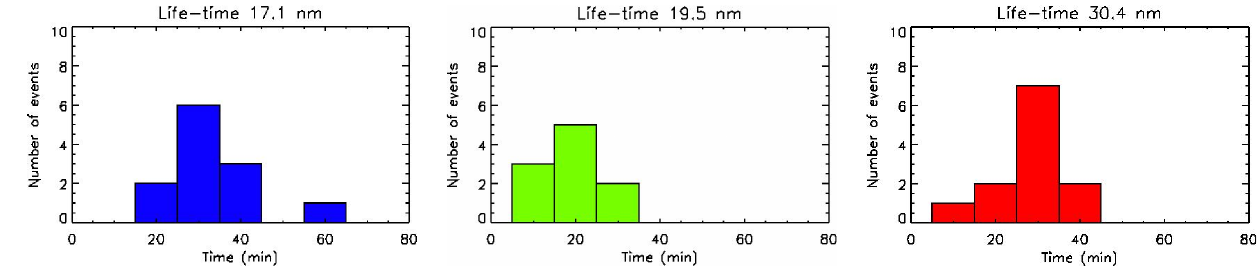
Fig. 2. Frequency distribution of the lifetimes of equatorial coronal hole jets at 171, 195, and 304 ˚A averaged in bins of 10min.